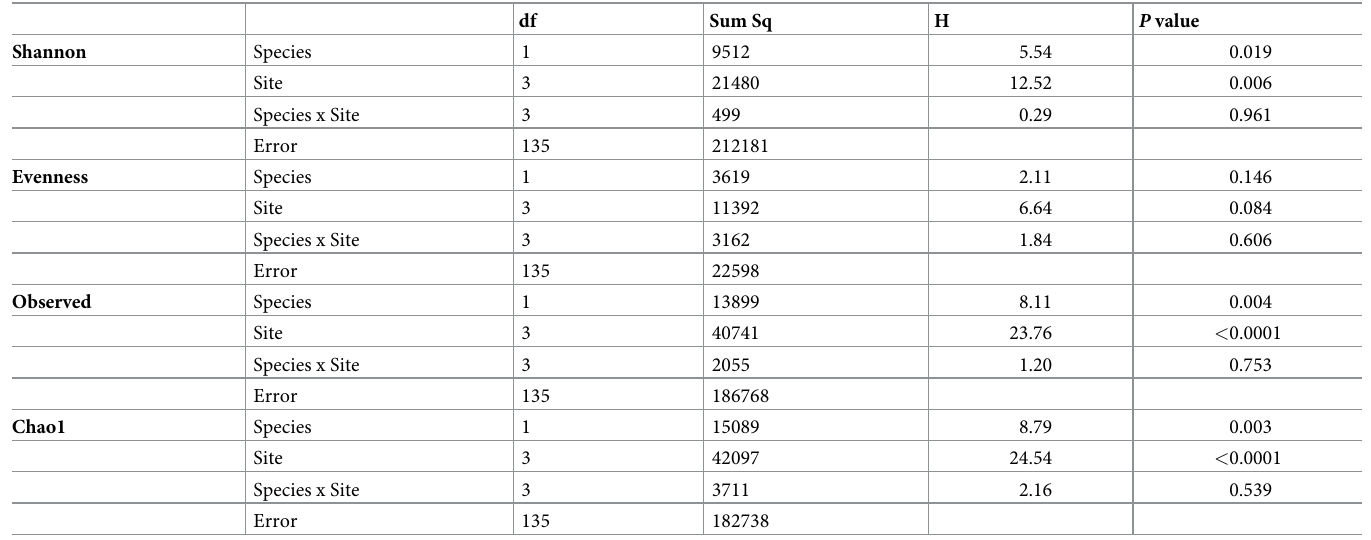
Table 2. Scheirer-Ray-Hare test results for the effect of mosquito species and site of collection on alpha diversity indices. df Sum Sq H P value Shannon Species